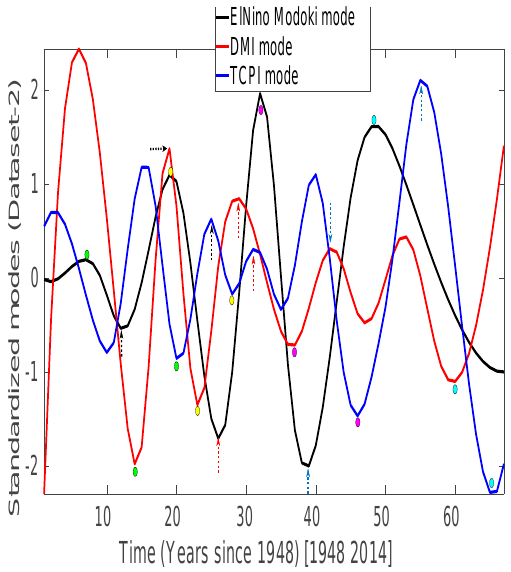
Figure 10. Mode comparison between TCPI, DMI and El Niño Modoki index using Dataset-1. TCPI and DMI are positively related to each other while El Niño Modoki relates negatively to both. A peak in the El Niño Modoki index is associated with the corresponding valleys in the DMI and TCPI modes.